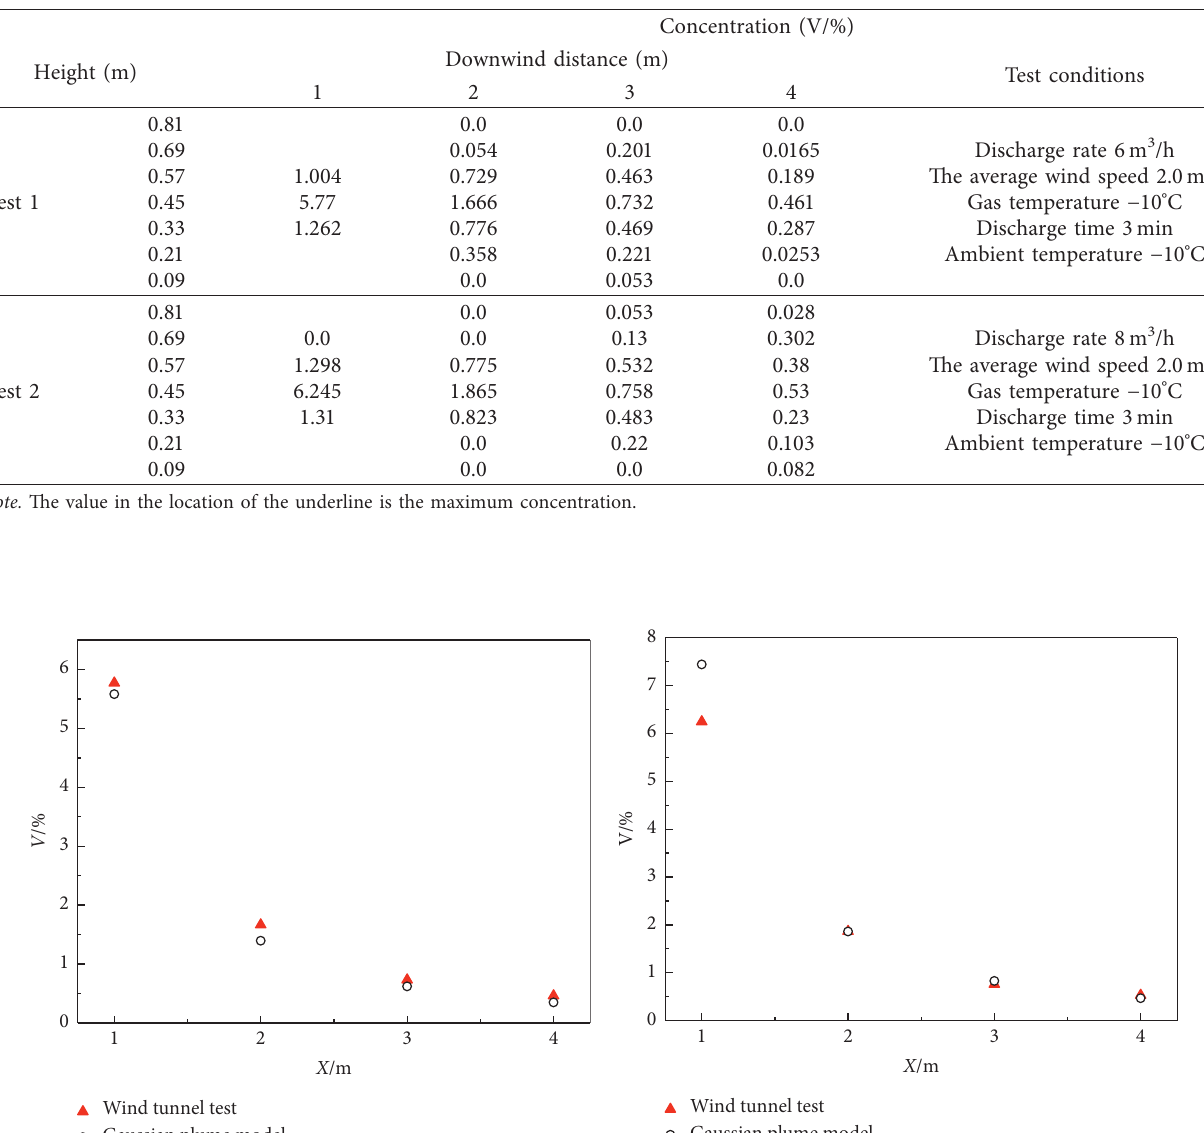
Figure 1: Schematic diagram of the experimental system [27]. Table 1: Wind-tunnel test data of acetylene diffusion